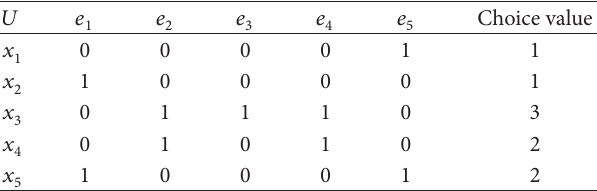
Table 10: The tabular representation of the midlevel soft set 𝐿(Δ ̃𝐹 ; mid ) with choice values in Example